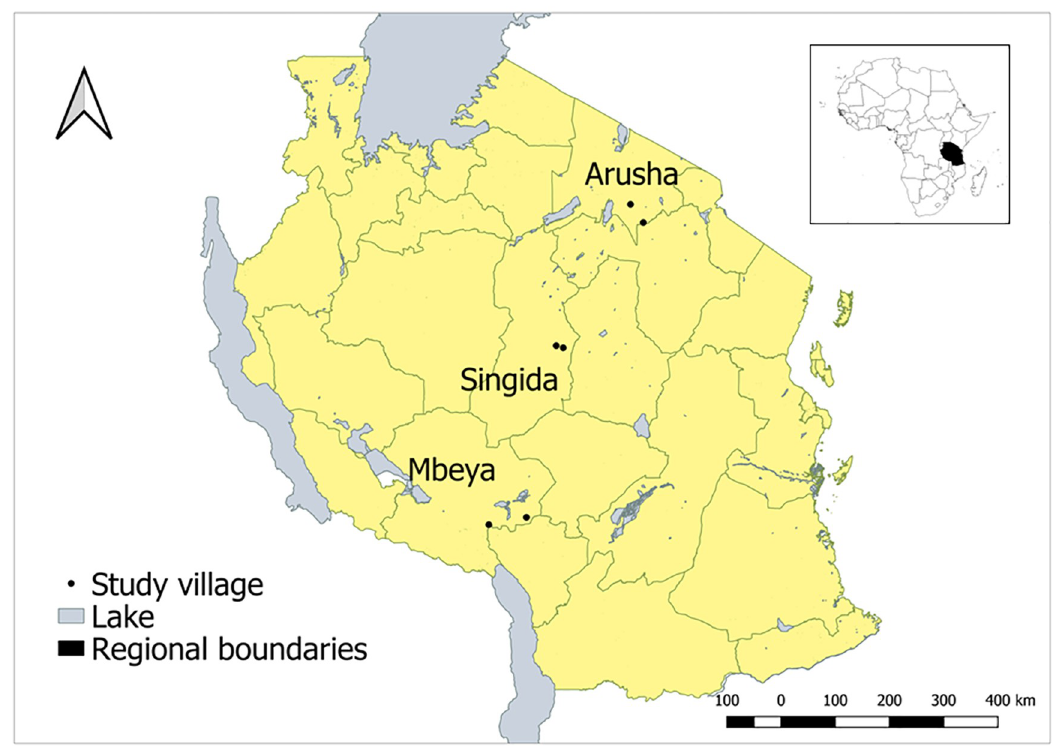
Fig 1. Study site